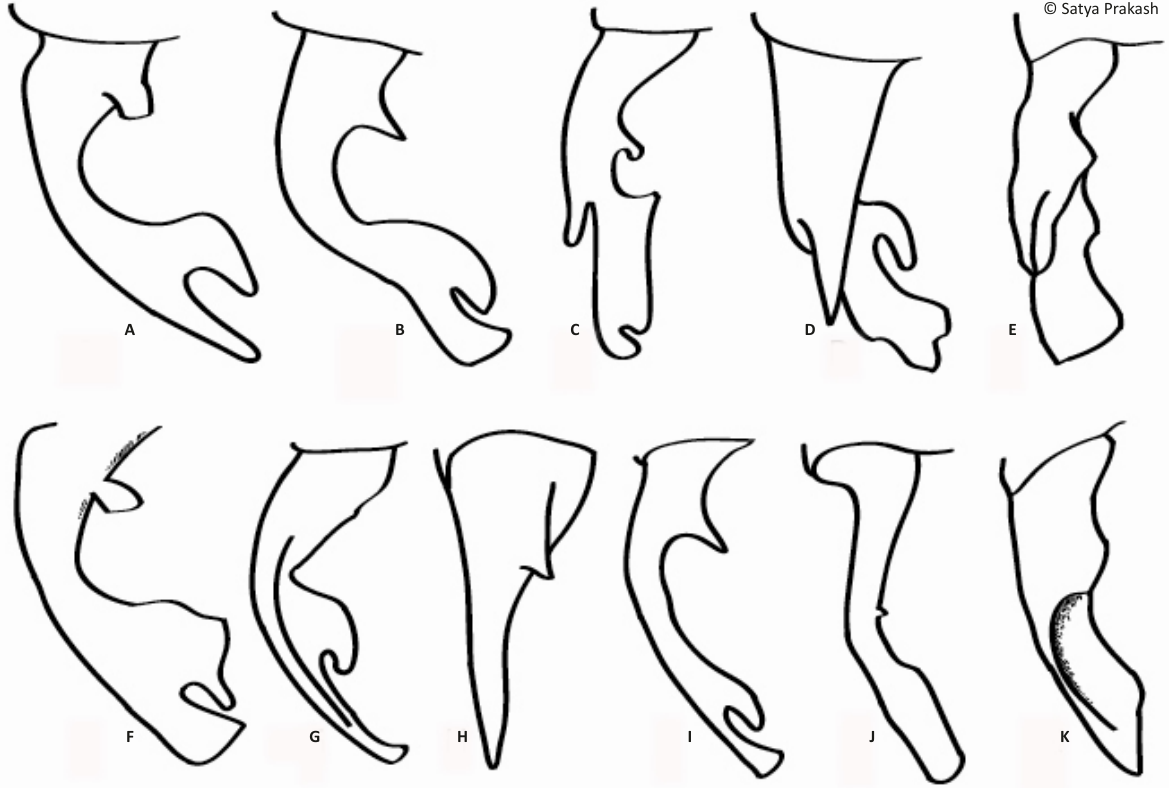
Figure 2. Superior anal appendages of Indian species of Protosticta, adapted from Fraser (1933). A - P. gravelyi , B - P. davenporti , C - P. antelopoides , D - P. sanguinistigma , E - P. damacornu F - P. rufostigma , G - P. mortoni , H - P. himalaica ,